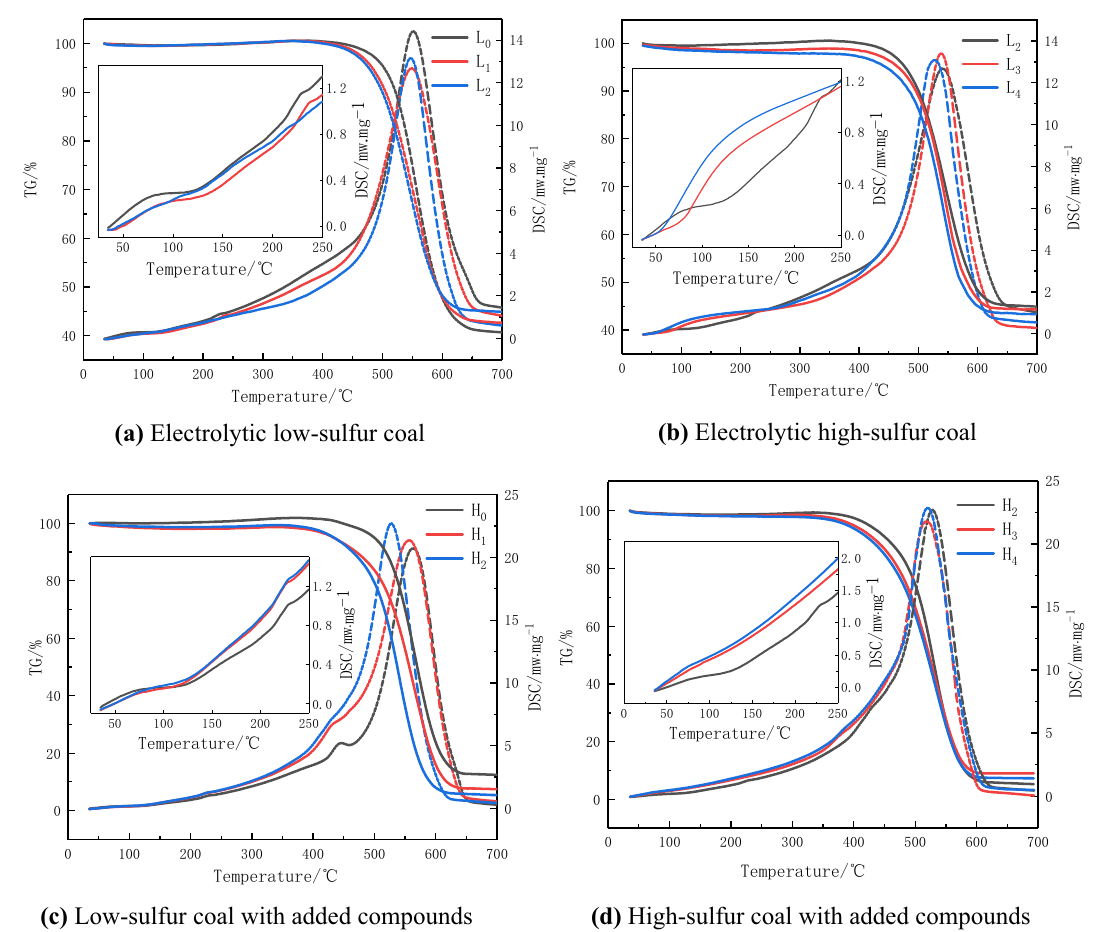
Figure 2. TG-DSC curves of coal samples before and after